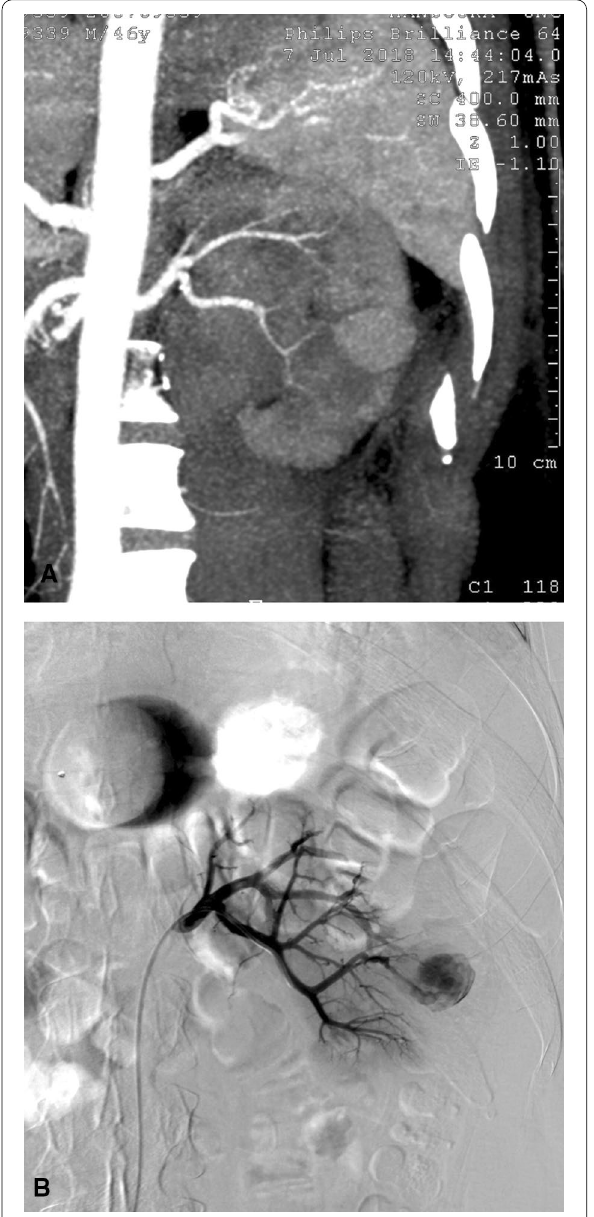
Fig. 1 Coronal CTA of left kidney in a 46‑year‑old male patient with hematuria after PCNL showing pseudoaneurysm from segmental lower branch ( A ). Selective left renal angiography of the same patient revealed the same findings ( B function, magnetic resonance angiography (MRA) was undertaken using two MRI machines; 1.5-T MRI (SIGNA Horizon, General Electric Medical Systems, Milwau- kee, WIS), and 3 Tesla MRI scanner (Phillips, Ingenia 3 T, Best, The Netherlands) after using gadolinium enhanced MRA with i.v. administration of 0.2 mmol/kg of Gadolinium; DOTAREM@ 0.5 mmol/ml (Guerbet,